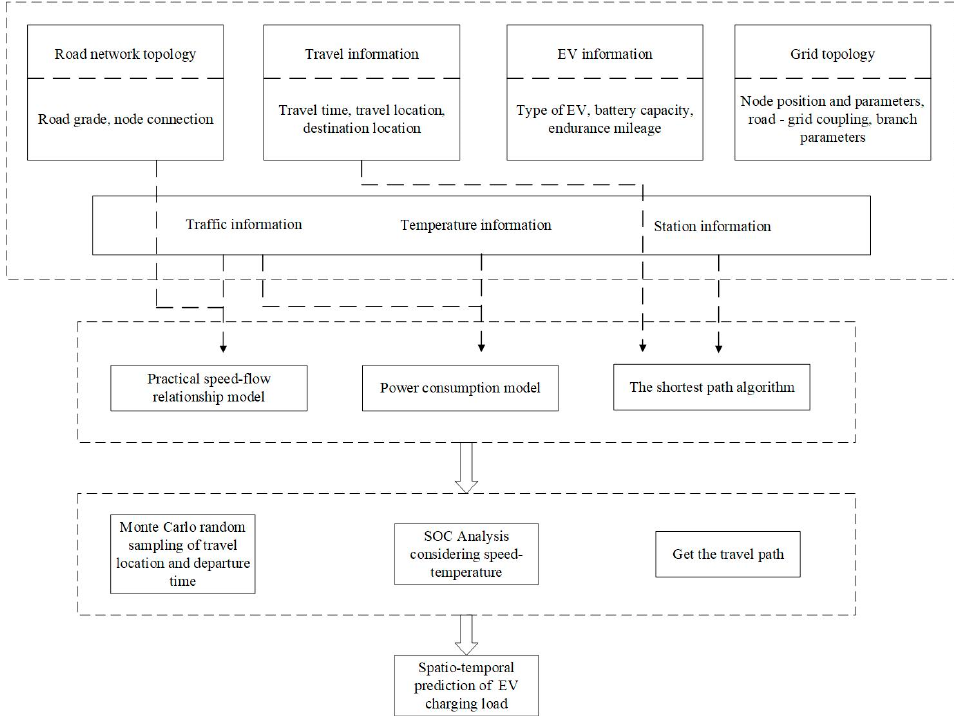
Figure 2. Spatio-temporal prediction framework of charging load considering velocity and temper- ature.